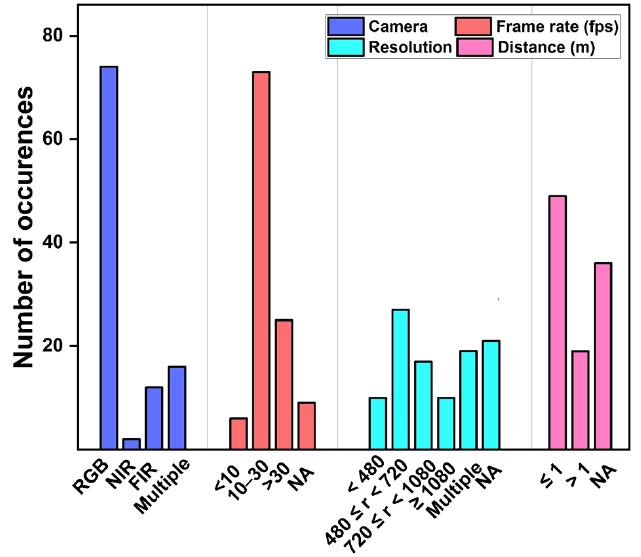
Figure 5. Distribution of hardware parameters, namely camera type, frame rate, resolution (r), and camera-subject distance.